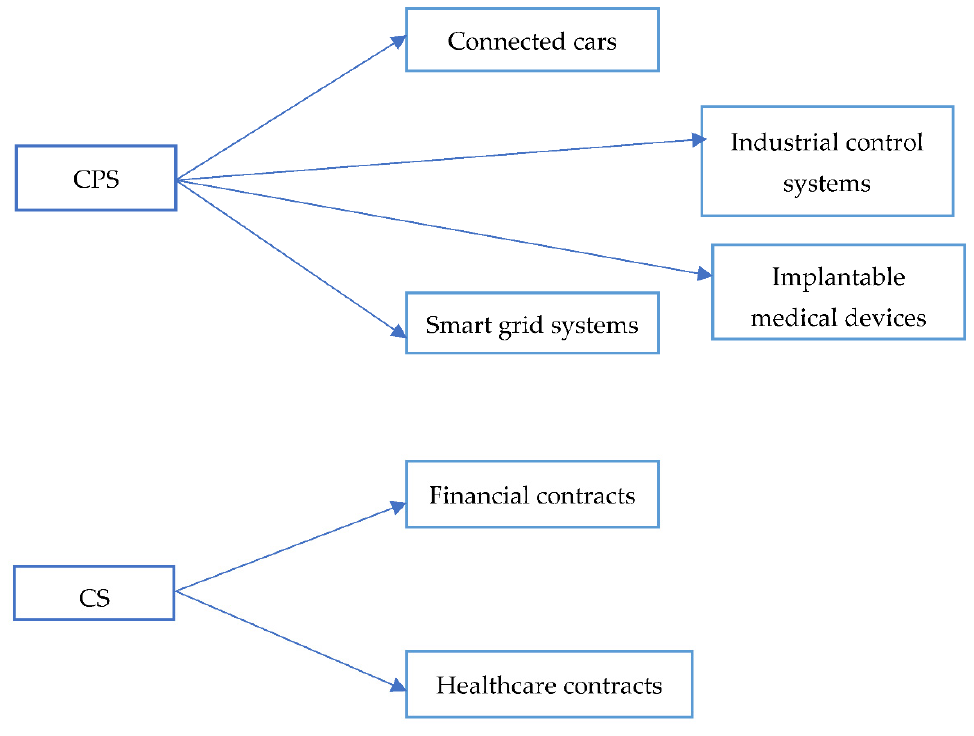
Figure 1. Four applications of CPS [6–13]. Table 1. Emerging important application domains of blockchain-based CPS. Table 1. Emerging important application domains of blockchain-based